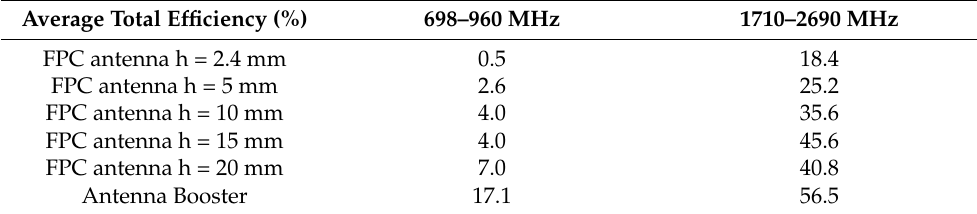
Table 5. Measured total efficiency for the FPC antenna and antenna